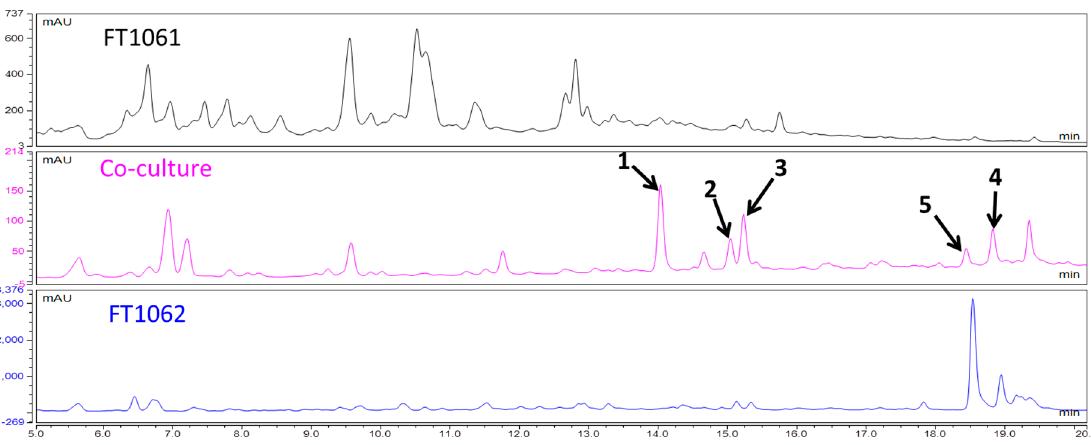
Figure 1. HPLC chromatograms of the EtOAc extracts from co-culture and single cultures of FT1061 and FT1062. (Peaks of compounds 1 – 5 in the chromatography of the extract from co-culture were marked).